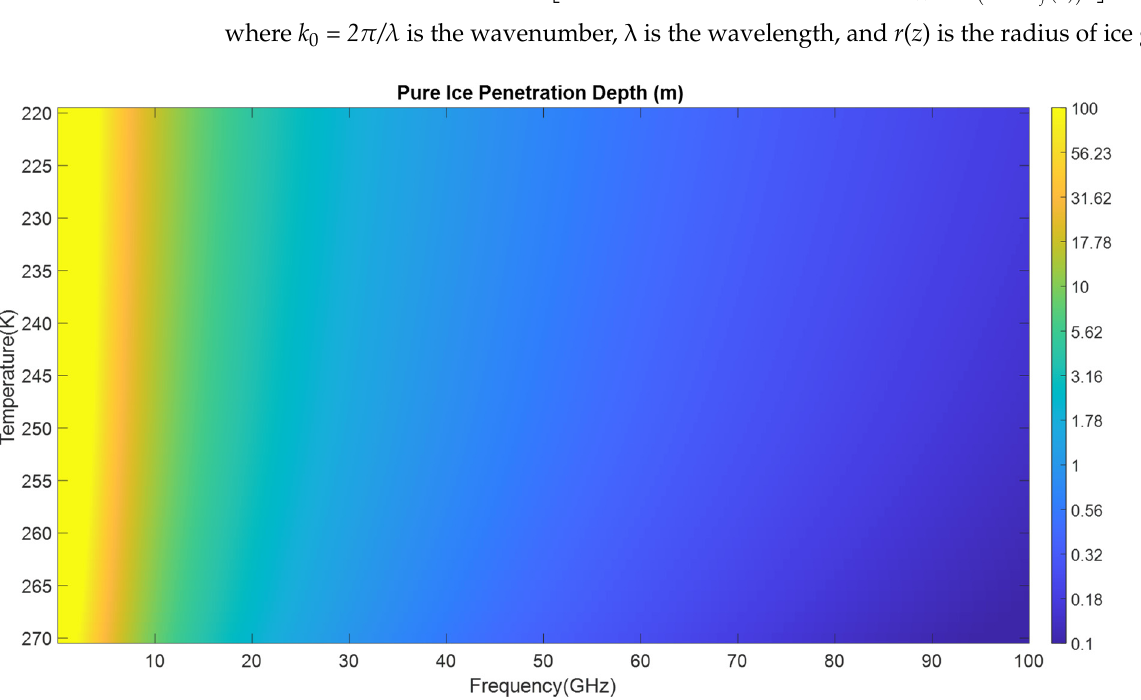
Figure 5. Electromagnetic penetration depth (in meters) in pure ice versus temperature and frequency below 100 GHz. Note the increase in penetration depth with lower frequencies and temper- atures.